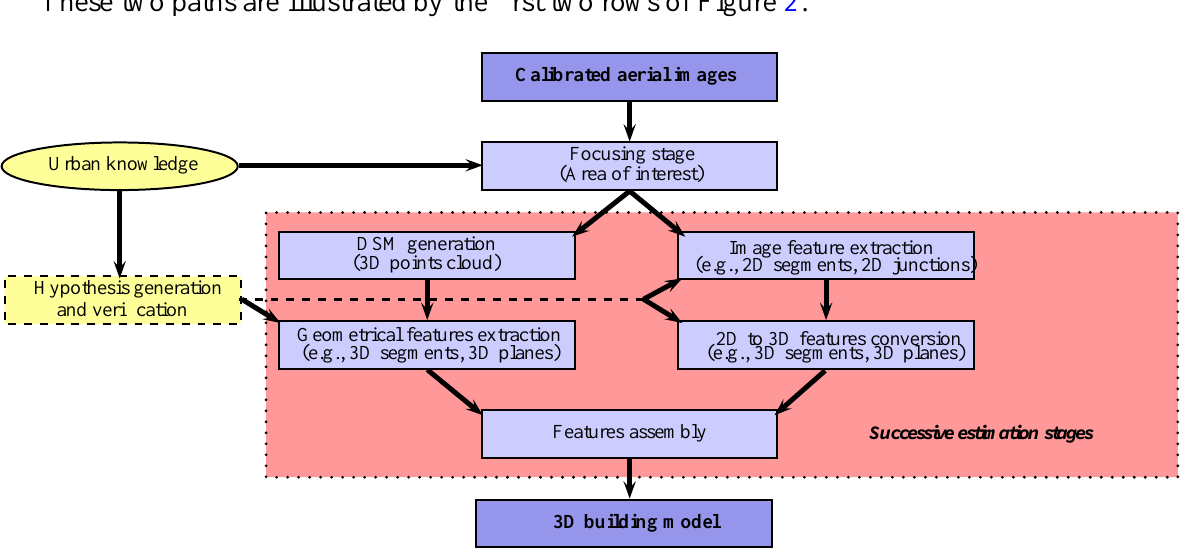
Figure 3. Flowchart diagram currently adopted by some image-based building modeling approaches. The diagram presents two paths conducting to 3D polyhedral building models. These two paths are illustrated by the first two rows of Figure 2.